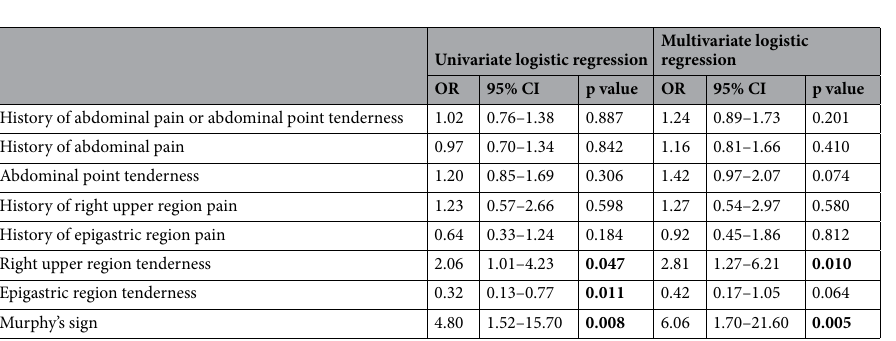
Table 3. Mortality and/or intensive care unit admission and/or intermediate care unit admission association with pattern of abdominal pain before and after adjustment for sex, age, abdominal surgery during hospital stay and dyspnea (complete case analyses). OR: odds ratio, CI: confidence interval. Significant values are given in bold.